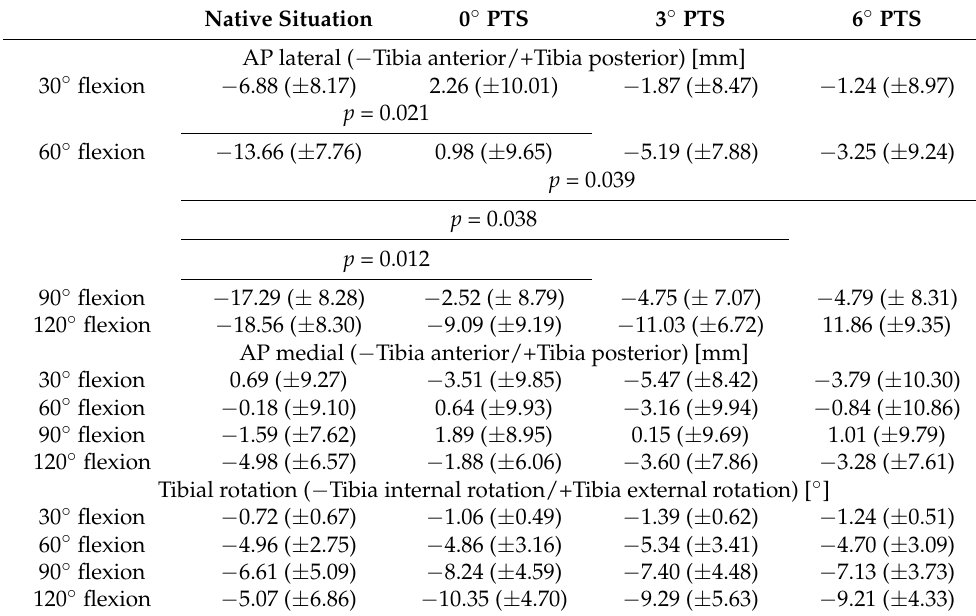
Table 1. Mean values ( ± standard